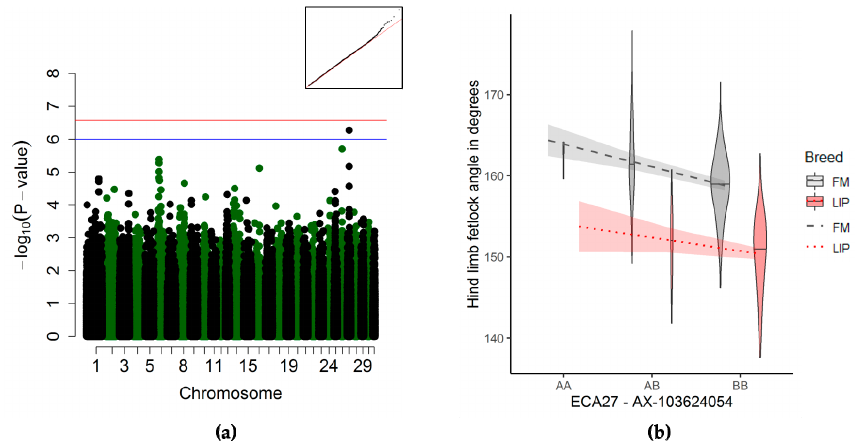
Figure 5. Genome-wide association study (GWAS) for the fetlock joint angle of the hind limb ( n = 495). (a) Manhattan plot and Q–Q-plot (inset) (blue line) representing the suggestive significance threshold ( p < 10 − 6 ) and (red line) the significance threshold (p Ind <2.66 × 10 − 7 ). (b) Violin plot and trend lines (standard error in translucent) representing the genotype effect of the significant SNP on ECA27 on the elbow joint angle.